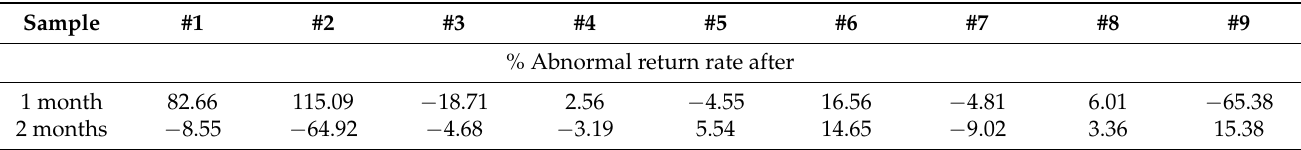
Table 4. Abnormal return rate with virtual demarcation day.